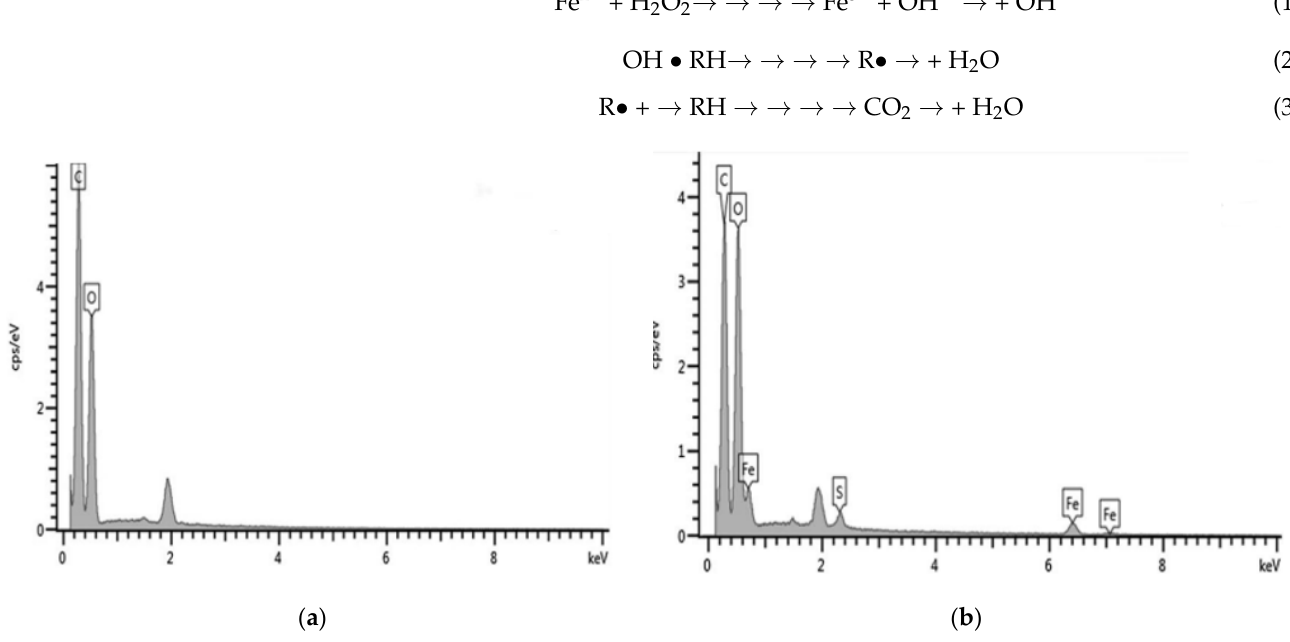
Figure 8. EDS analysis of ( a ) untreated KF and ( b ) modified KF using Fenton reaction [73]. Reprinted by permission from Springer Nature Customer Service Centre GmbH: Springer Nature, Environ- mental Earth Sciences, Removal of lead (II) from aqueous stream by hydrophilic modified